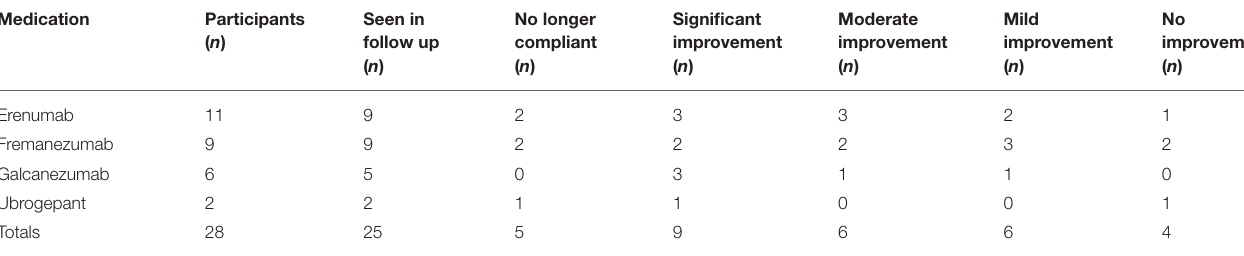
TABLE 3 | Results of